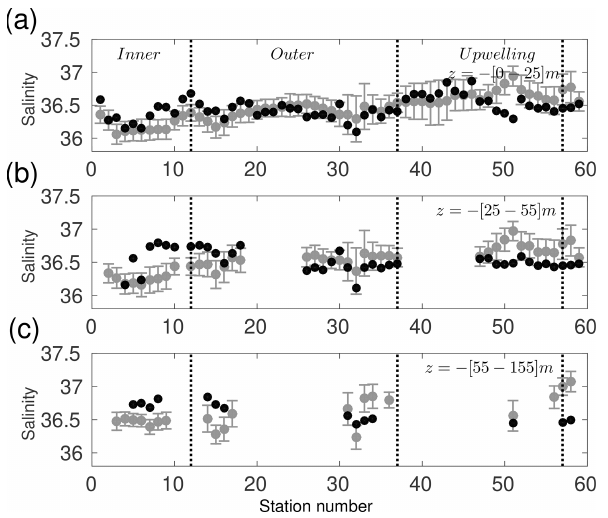
Figure 5. Same as Fig. 4, but for salinity. Figure 6. Same as Fig. 4, but for chlorophyll concentrations (mgChlm − 3